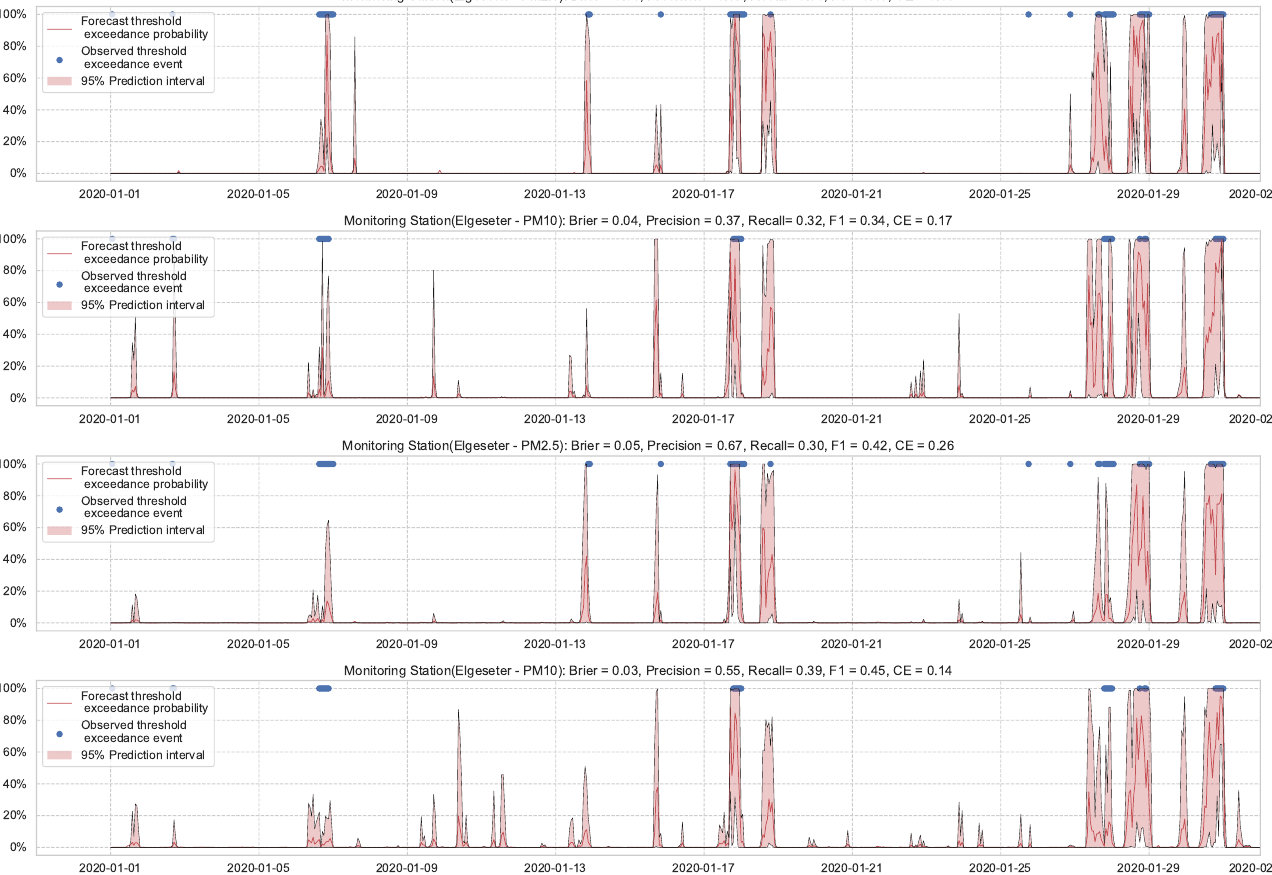
Figure 24. Comparison of uncertainty estimation in threshold exceedance classification when training ( top ) without adversarial training versus ( bottom ) without adversarial training. Using Adversarial training leads to smoother predictive distribution; thus, lower CE (less overconfident